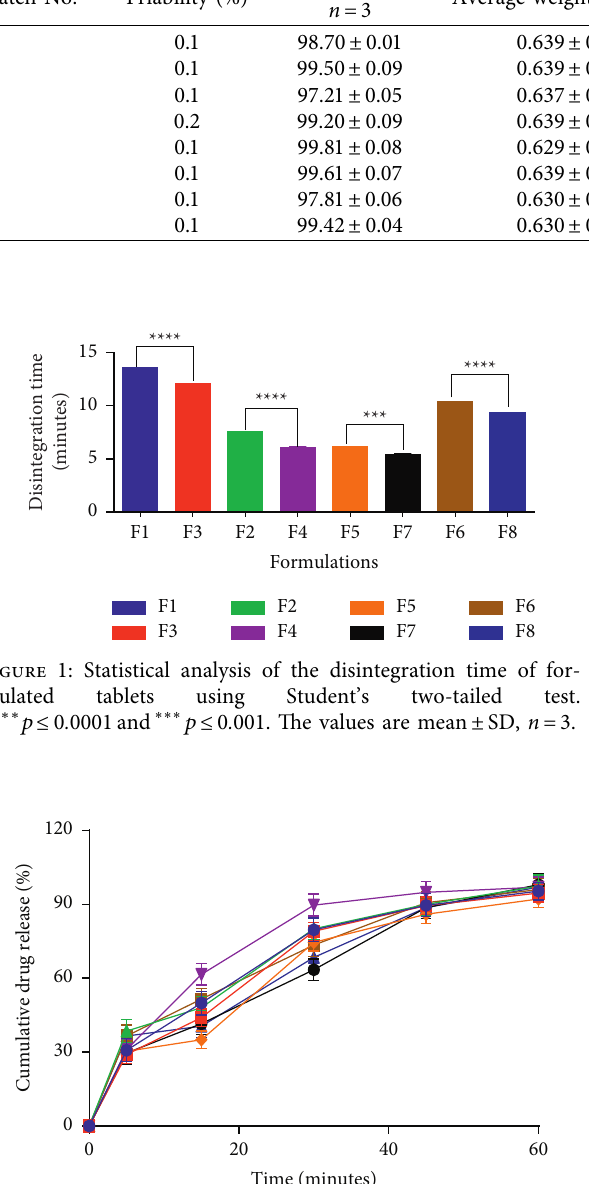
Table 5: Physicomechanical properties of the batches of paracetamol tablets produced. Batch